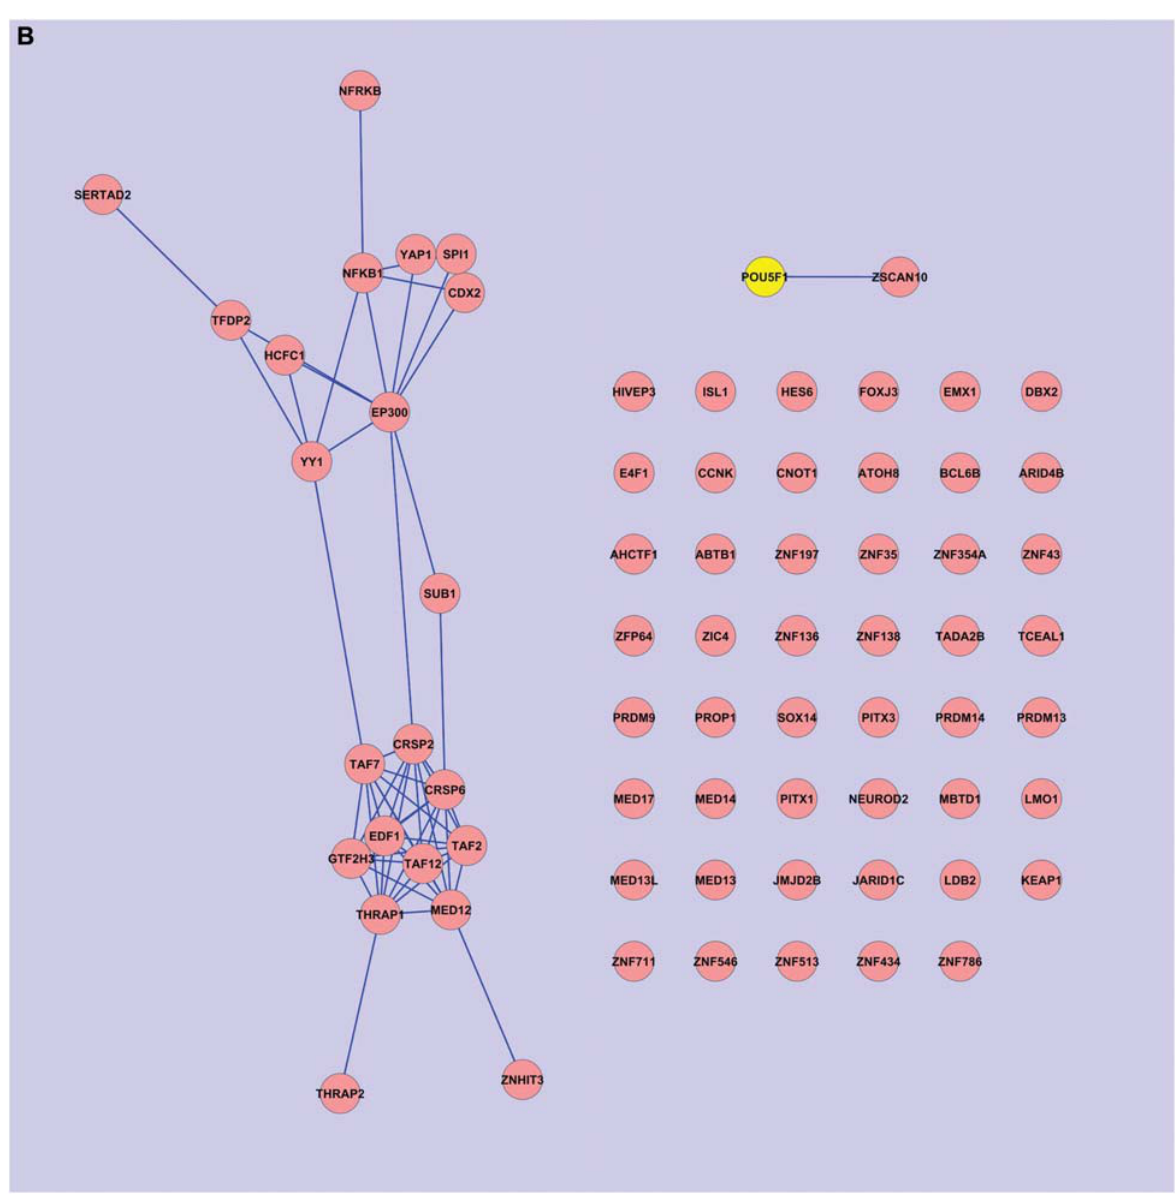
Figure 3 Protein interaction network of transcription factors in the embryonic stem cell of mouse and human. (A) The mouse network is constructed based on transcription factors interacting with pluripotency-associated factors, Oct4, Nanog, Sall4, Dax1, Esrrb, Tcfcp2l1, Nac1, Zfp281 and Zfp42 (alias Rex1) (36–39). Oct4 is marked yellow. Transcription factors interacting with more than one other transcription factor (inside the circle) could represent the phenomenon of transcription factor clustering for the activation of ES cell genes. For two studies (38, 39), names of proteins were updated to the official one (with the original names used in the publication in parentheses) so that they are consistent across all the studies. Protein functions where not given were also annotated based on gene